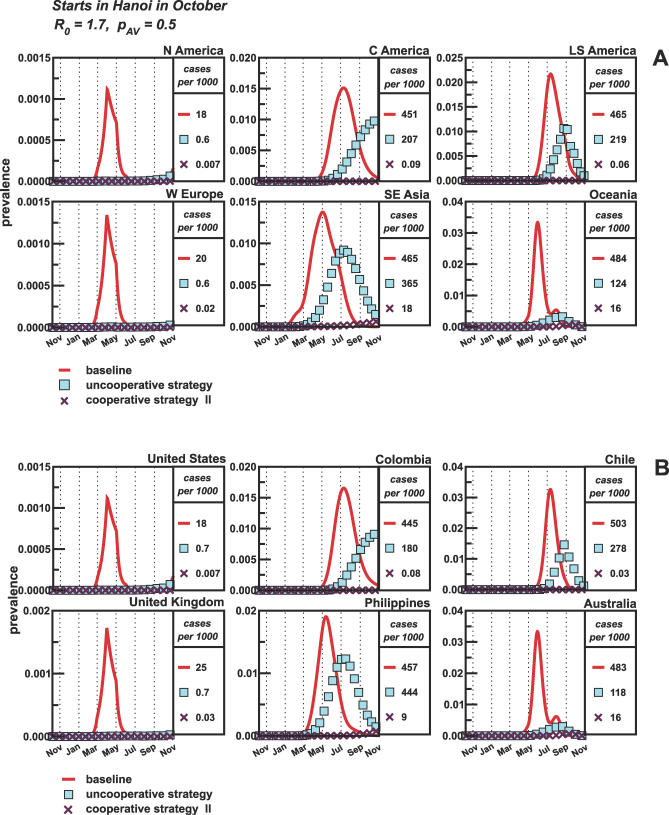
Intervention Scenarios with Limited AV Supplies: Expected Pandemic EvolutionAverage prevalence profiles expected in the baseline case and the different intervention scenarios under study for a pandemic starting in Hanoi in October. Profiles for six global regions (A) are shown together with six illustrative examples of countries profiles (B), each taken from the corresponding region. For the sake of simplicity, only one cooperative strategy is shown, namely cooperative strategy II. Here R0 = 1.7 and AV drugs, when available, are distributed to symptomatic infectious individuals who enter the AV treatment with a rate pAV = 0.5/d. The first 12-month period after the start of the pandemic is shown. The average attack rate after one year is reported for all regions/countries and containment strategies.